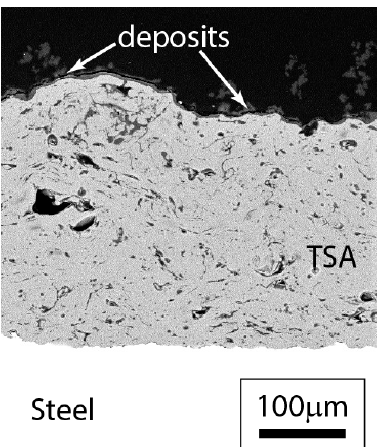
Figure 13. Micrographs of cross-sections of TSA on AISI 4137 at − 1100 mV.